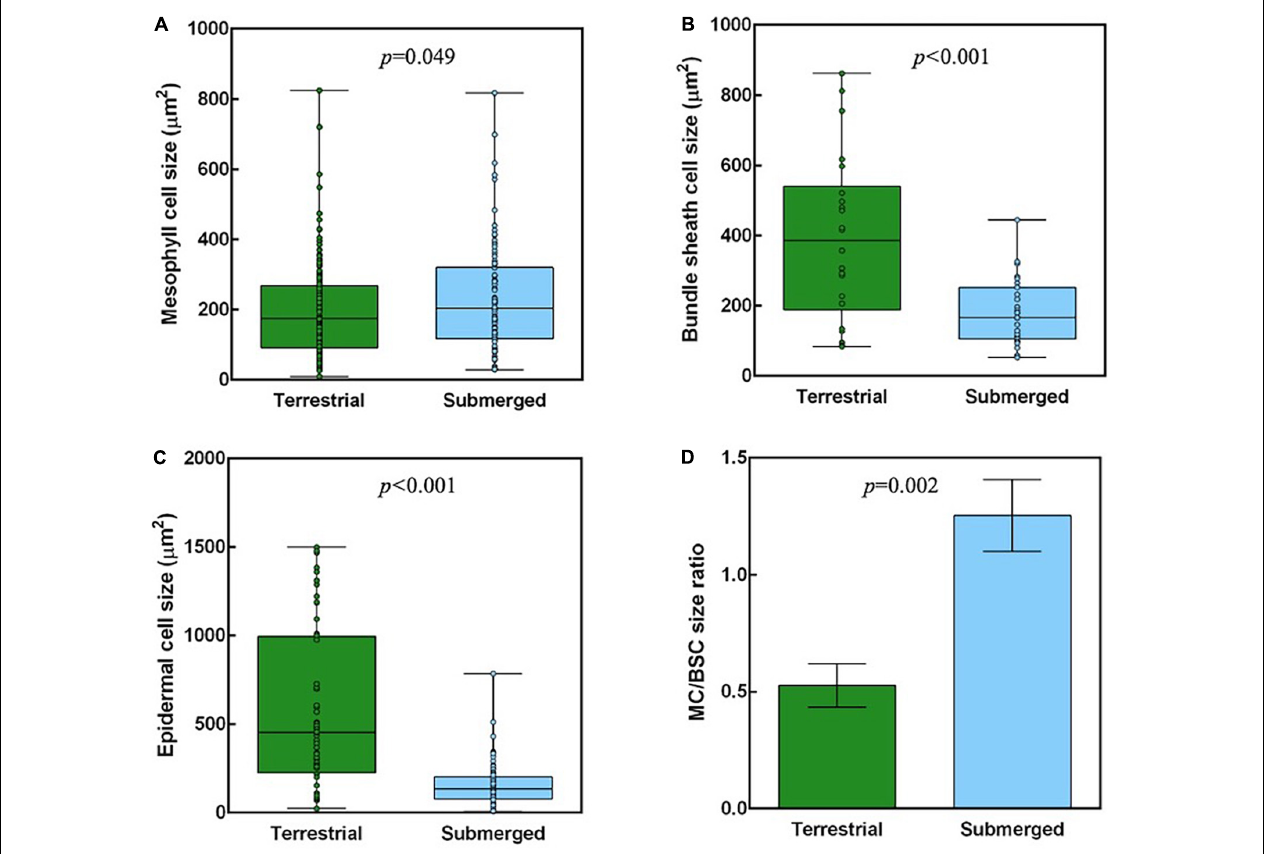
FIGURE 6 | Anatomical measurements of H. polysperma leaves that developed under terrestrial and submerged conditions. Cell sizes of mesophyll cells (A) ; bundle sheath cells (B) ; epidermal cells (C) and the size ratio of mesophyll cells (MCs) to Rubisco in bundle sheath cells (BSCs) (D) . (A–C) Cell sizes were measured for all cells in the profile area (W370 µ m) from three independent biological replicates. Boxes indicate the 25th and 75th percentiles, with medians indicated by the horizontal line in the box. The open circles in the boxes show the raw data. (D) The ratio of MC to BSC size was calculated from averages of MC and BSC sizes in each sample. The data were analyzed with Student’s t test, and the results are expressed as means ±